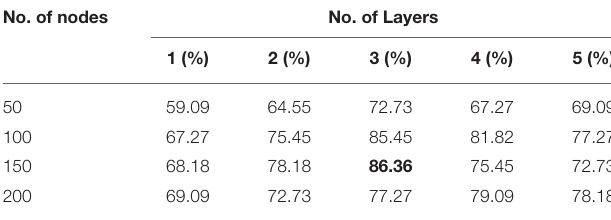
FIGURE 6 | An example of the representation of learnt features from DNN (Connections used to construct features are presented by solid arrows).